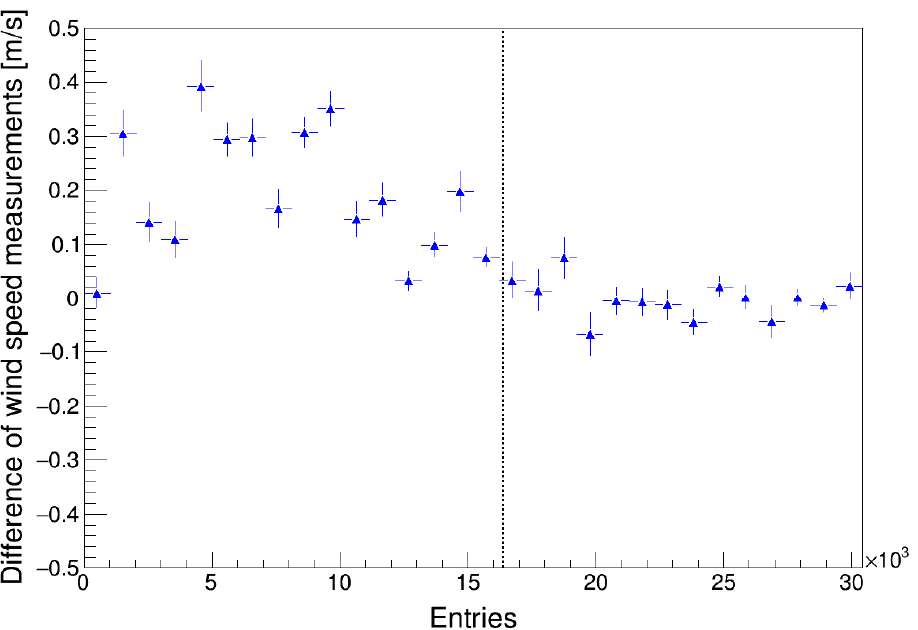
Figure 11. Difference between the wind speed measured by both anemometers is plotted regarding the data (entries) organized from the first to the last. The Anemometer 2 recalibration event (see Table 1) is plotted with a vertical dashed line.